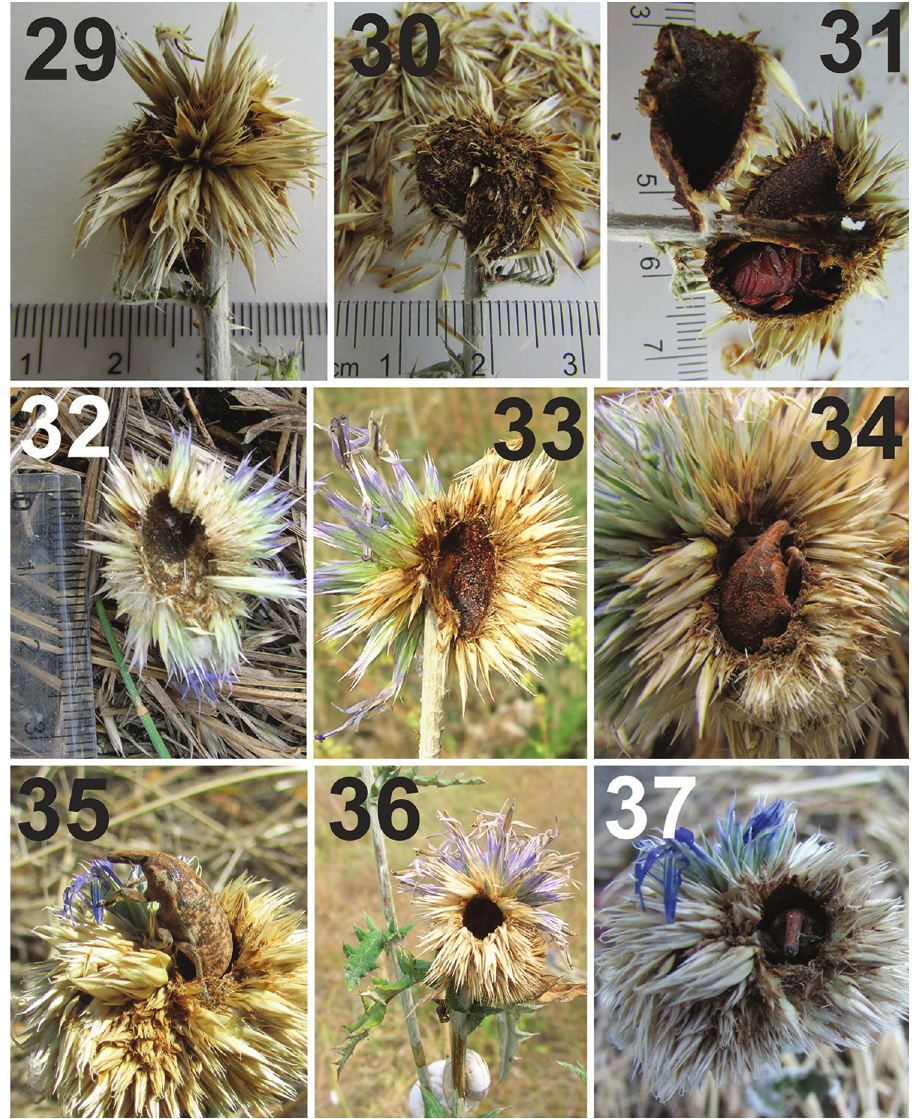
Figures 29–37. Hatching, pupal cells, and adults of Larinus vulpes . 29 Dead inflorescence with pupal cell inside 30 Pupation cell and dry fragments removed from outside of the cell 31 Pupation cell with a fresh, not fully coloured adult 32 , 33 Pupation cell at the beginning (left) and after finishing construction. The inner layer of the finished wall is hard and glanced 34 Adult in pupation cell 35 Adult leaving the pupa cell 36 Exit hole of adult of new generation 37 Fresh adult in pupa cell. All photos: SV Volovnik. seven capsules were located on the same stem and touched one another. The largest chamber was approximately 0.7 × 1.25 cm. The walls of all chambers were solid but rather brittle and easily crushed by the fingers. The material of the walls had no